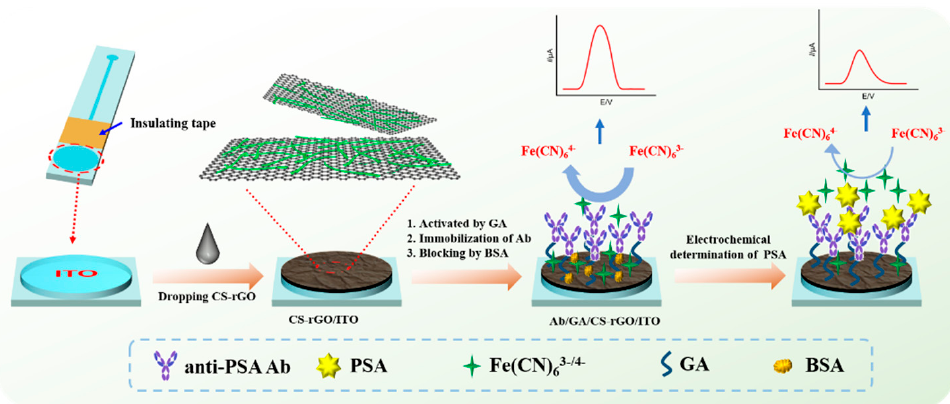
Figure 1. Schematic illustration of the facile fabrication of the immunosensor and amperometric determination of PSA.